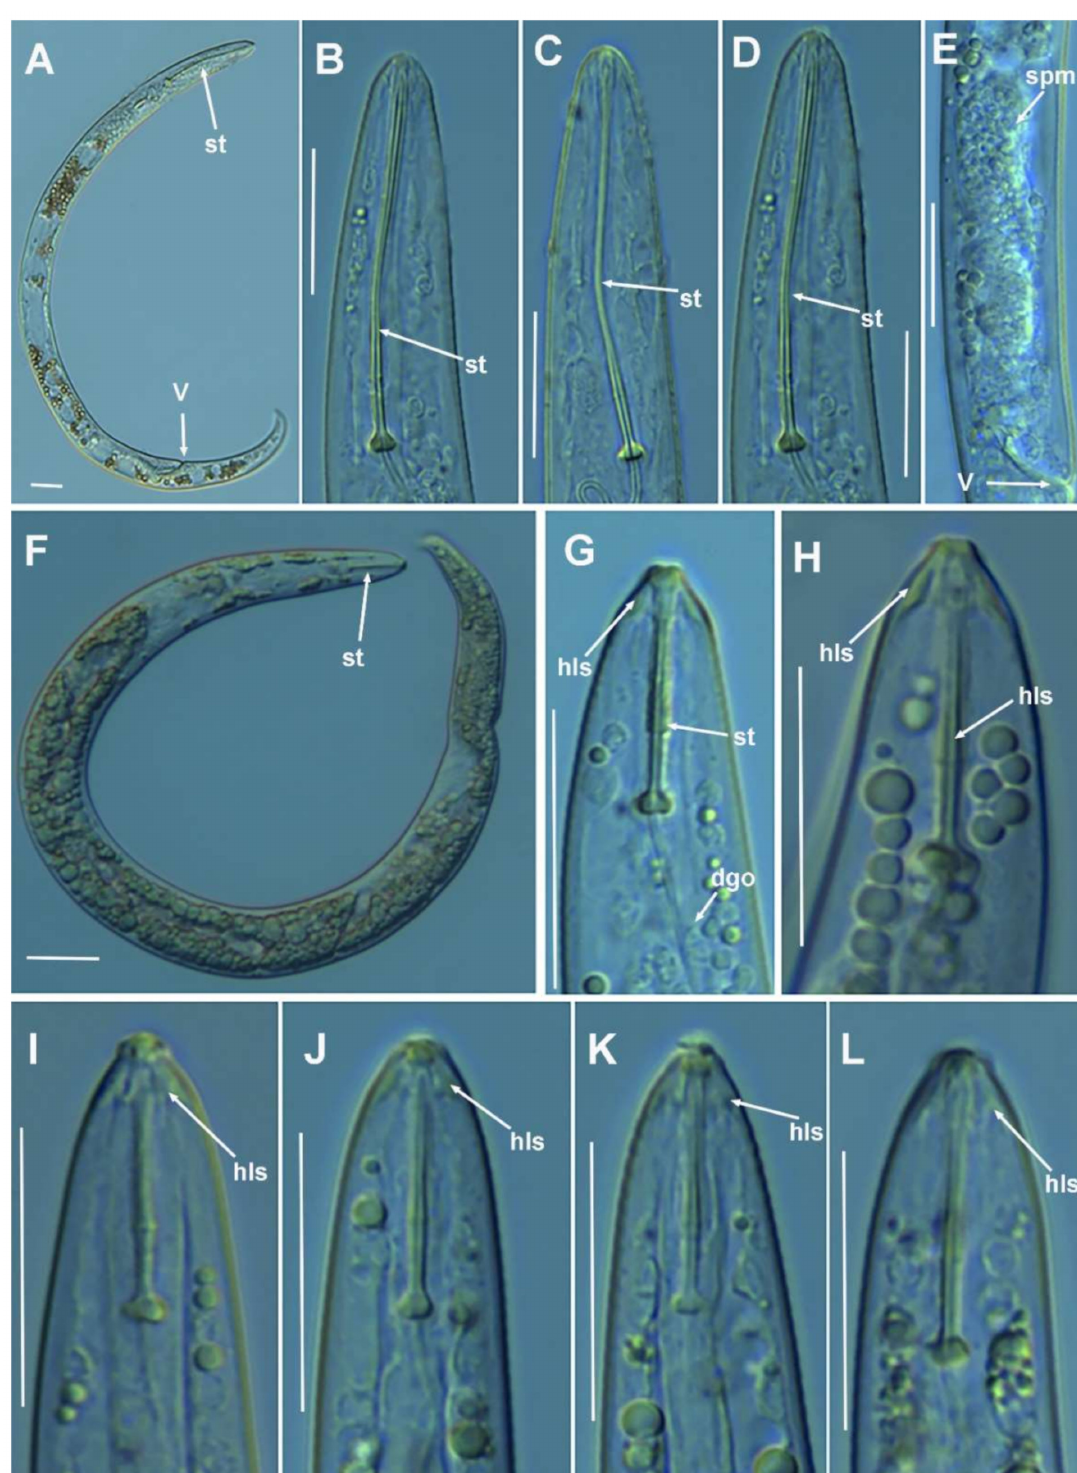
Figure 6. Light photomicrographs of Paratylenchus goodeyi Oostenbrink, 1953. ( A ) Entire female with vulva arrowed; ( B – D ) female lip region with stylet arrowed; ( E ) detail of vulval region showing spermatheca arrowed; ( F ) entire fourth- stage juvenile with short stylet arrowed; ( G – L ) fourth-stage juvenile lip regions showing labial sclerotization and short stylet (arrowed). Scale bars ( A – L = 20 µ m). (Abbreviations: dgo = pharyngeal dorsal gland orifice; hls = heavy labial sclerotization; spm = spermatheca; st = stylet; V =